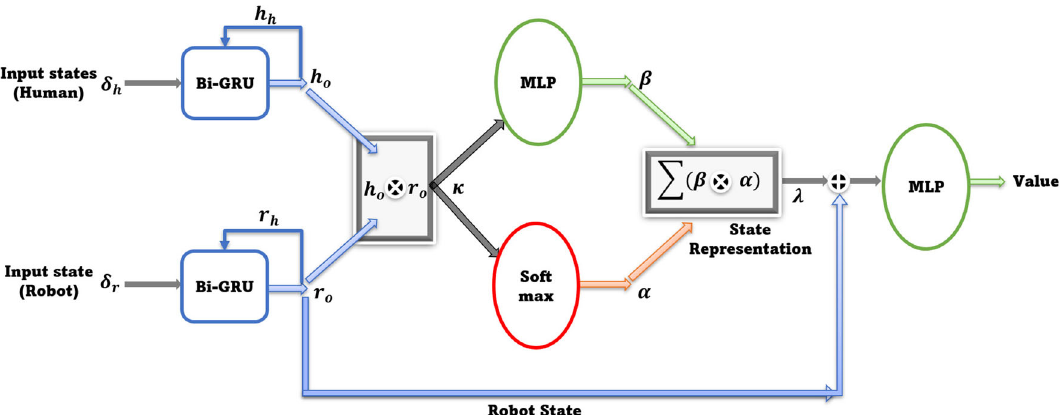
Fig. 4 Network architecture of the proposed model